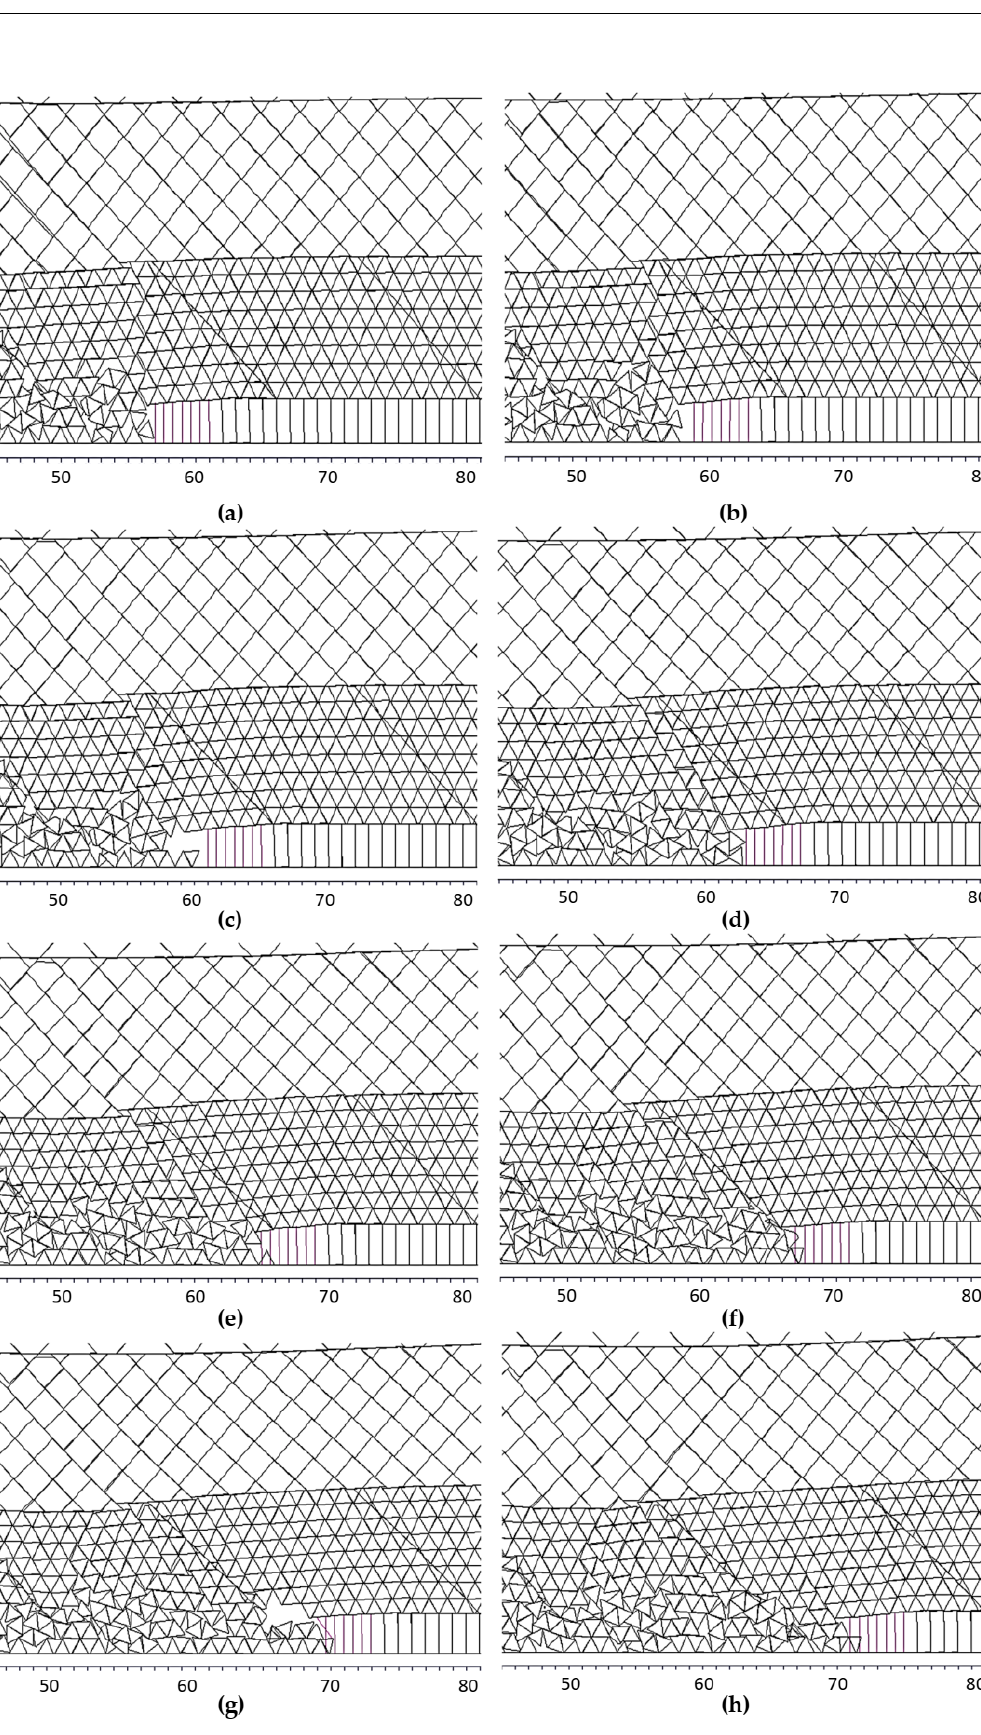
Figure 9. The formation of goafs in the model including hydraulic fracturing.